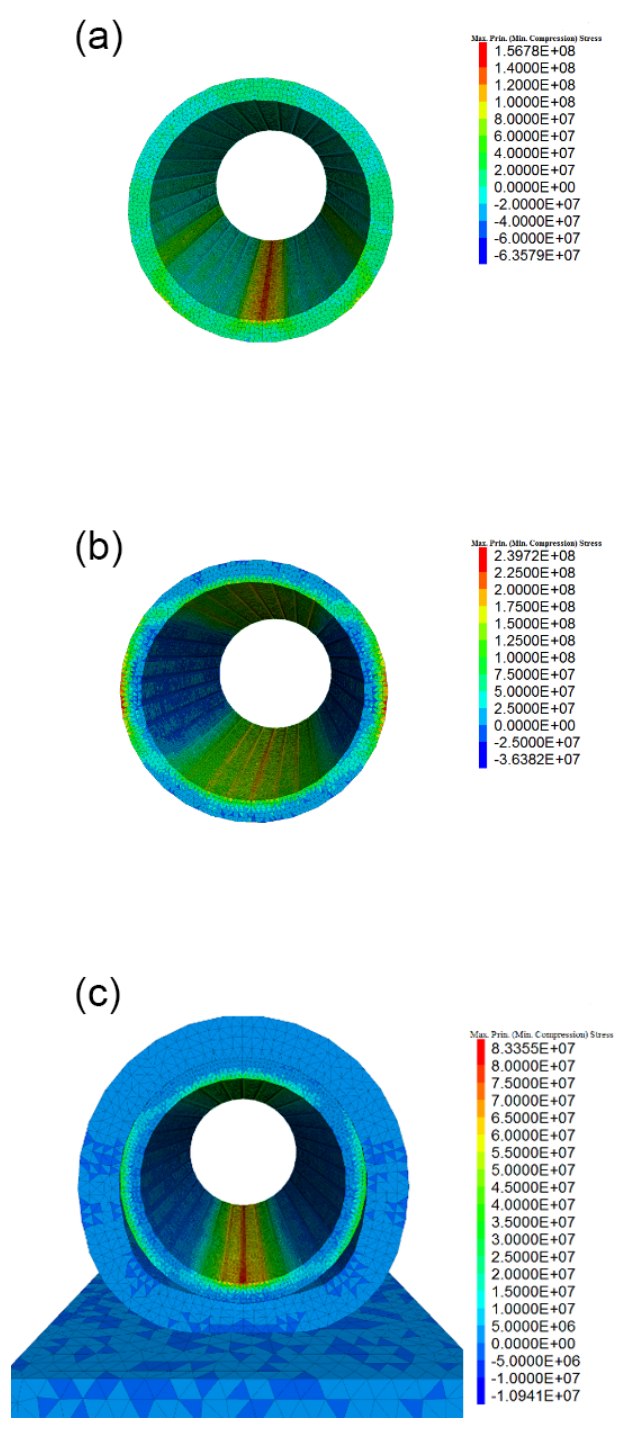
Figure 10. (a) Initial maximum principal stress [Pa]. (b) Maximum principle stress [Pa] during impact. (c) Maximum principal stress [Pa] (canister with coating).